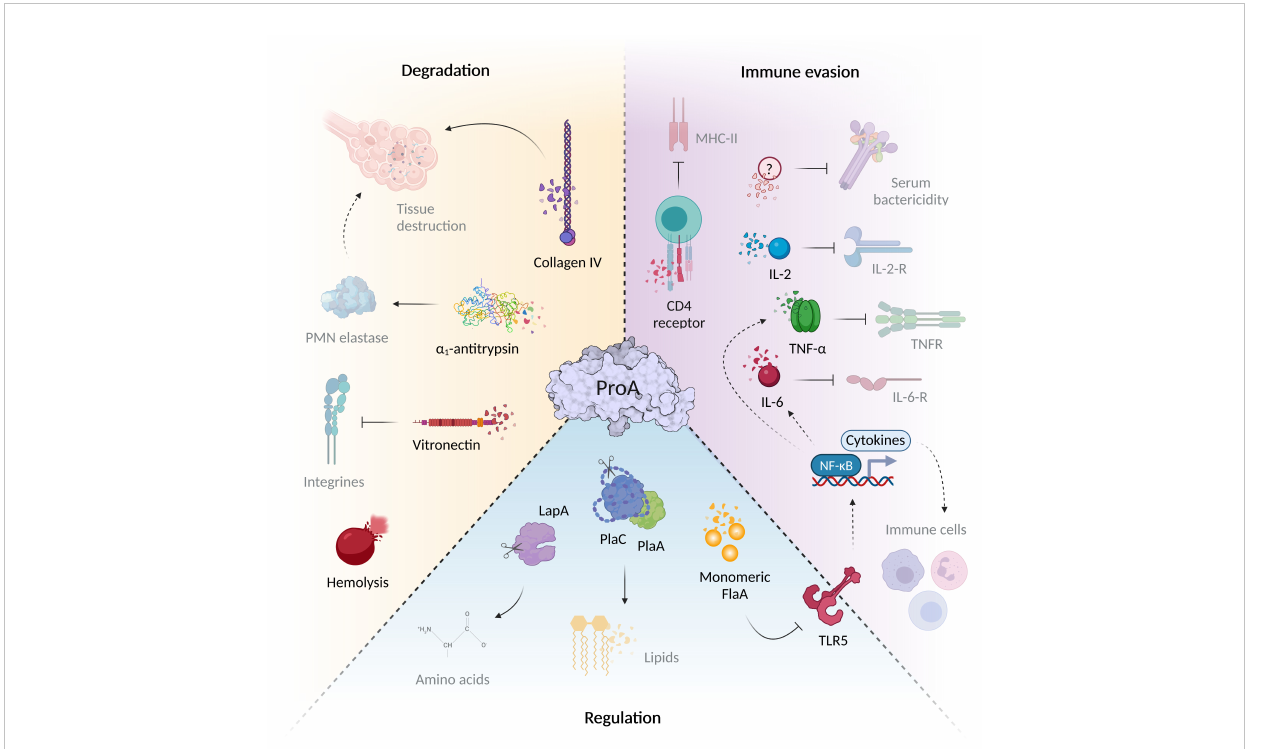
FIGURE 1 ProA mediates virulence regulation, host tissue degradation and immune evasion. The virulence factor ProA can interfere with a wide variety of infection-associated processes via the diverse range of substrates. During Legionnaires ’ disease, it signi fi cantly mediates tissue degradation due to structural host targets such as collagen IV of the basal lamina and the cell adhesion protein vitronectin. ProA also cleaves a 1 -antitrypsin, important for controlling of host proteases. In addition, ProA exhibits hemolytic properties and contributes signi fi cantly to immune evasion. The zinc metalloprotease not only cleaves humoral serum components and chemokines (IL-2, IL-6, TNF- a ), but also in fl uences the recruitment and proliferation of various immune cells via these signaling molecules of speci fi c surface receptors. However, ProA also attacks cellular structures directly, for example, by degrading the CD4 receptor. Aside from host targets, the protease also affects other bacterial proteins that play an important role during the intracellular life cycle of L. pneumophila . Via cleavage of exogenous fl agellin, the TLR5-mediated immune response and thus the cytokine expression are reduced. Through direct processing, ProA can additionally activate virulence factors such as PlaA/PlaC and LapA, which contribute to lipid degradation at the LCV and amino acid synthesis (created with